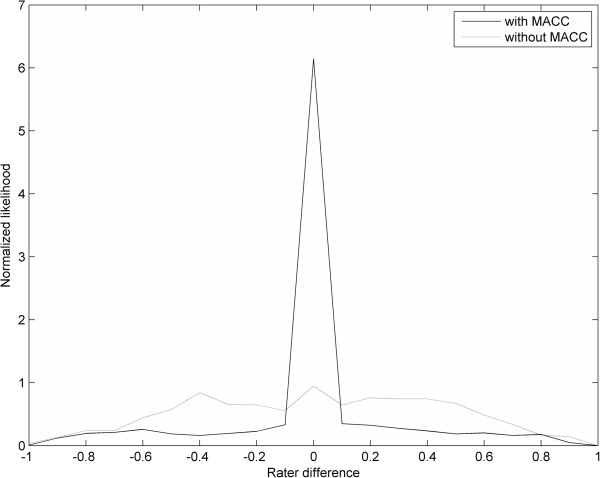
The graph with the sharp peak is the Outline Error Distribution (OED) graph of MACC (ROI(r1, im), im) and MACC (ROI(r2, im), im), and indicates that most compared ROIs have near zero area disagreement. The flatter graph is the Outline Error OED graph of ROI(r1, im) and ROI(r2, im), and indicates a broad range of area disagreement between corresponding ROIs. Negative abscissa values indicate that operator 1’s ROIs are larger than operator 2’s ROIs, and positive values indicate the opposite.